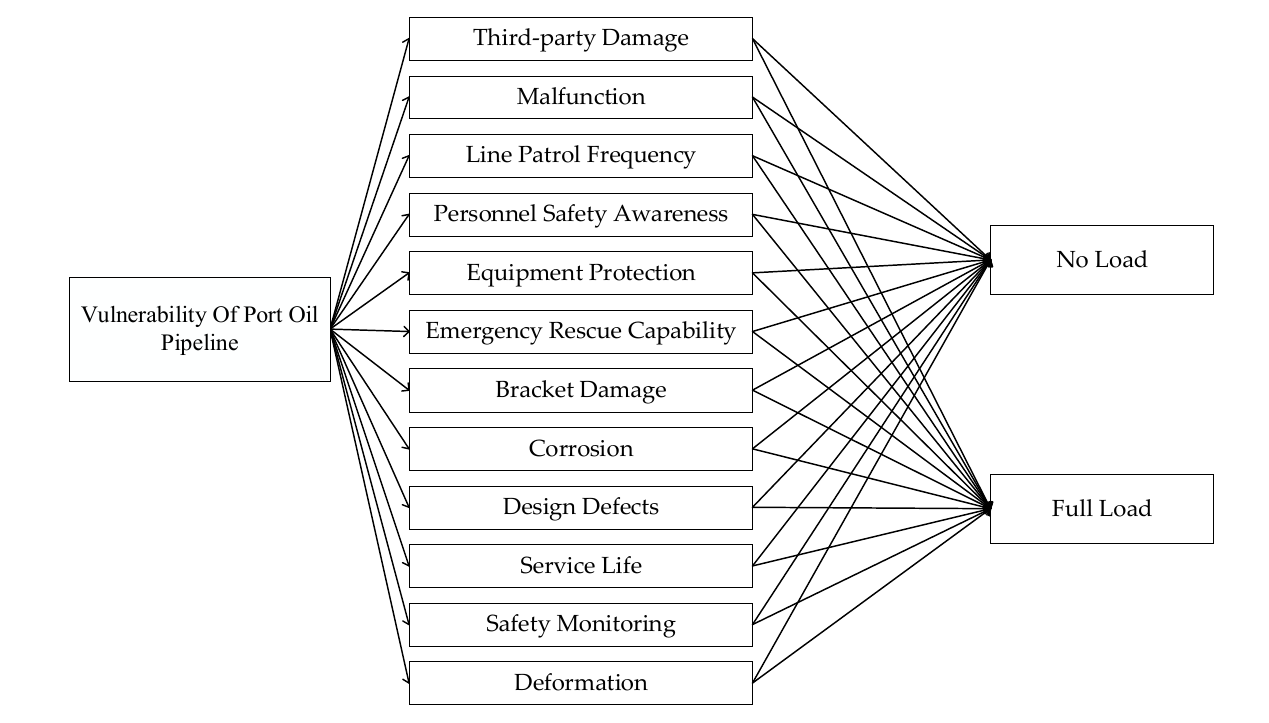
Figure 5. Vulnerability evaluation index system for pipelines under typhoon impact.